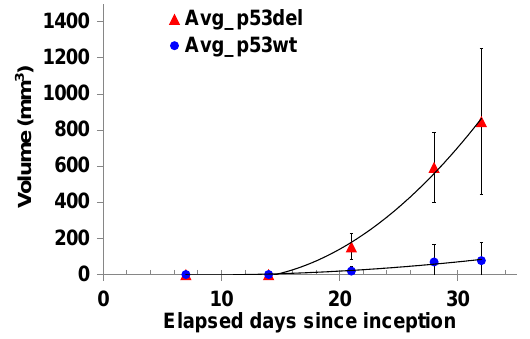
Fig. 1. Tumor growth